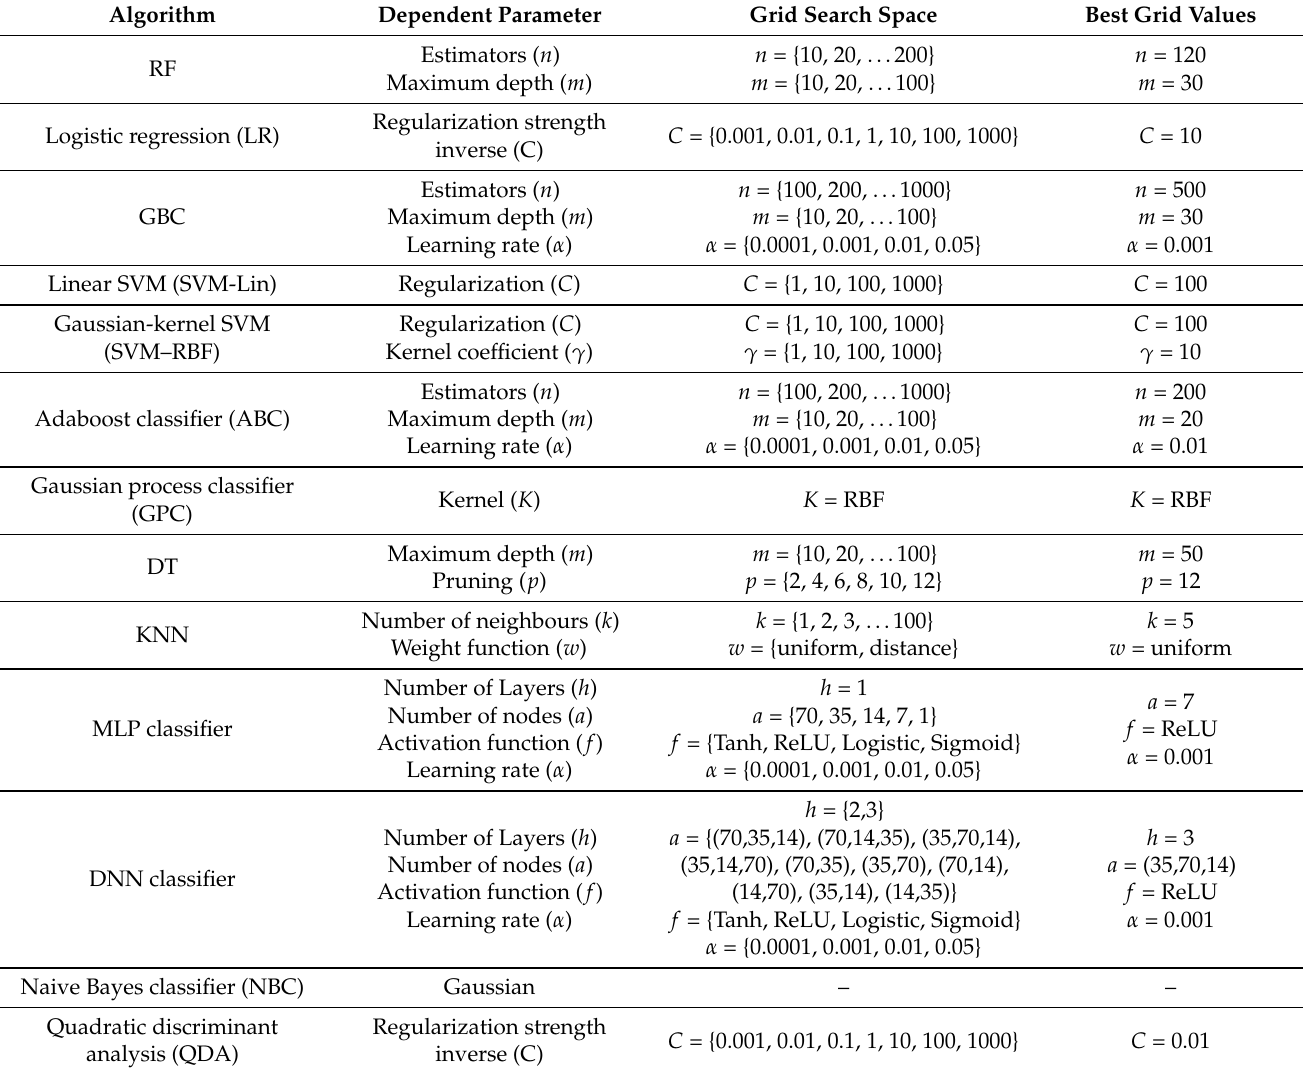
Table 2. Optimal parameters for